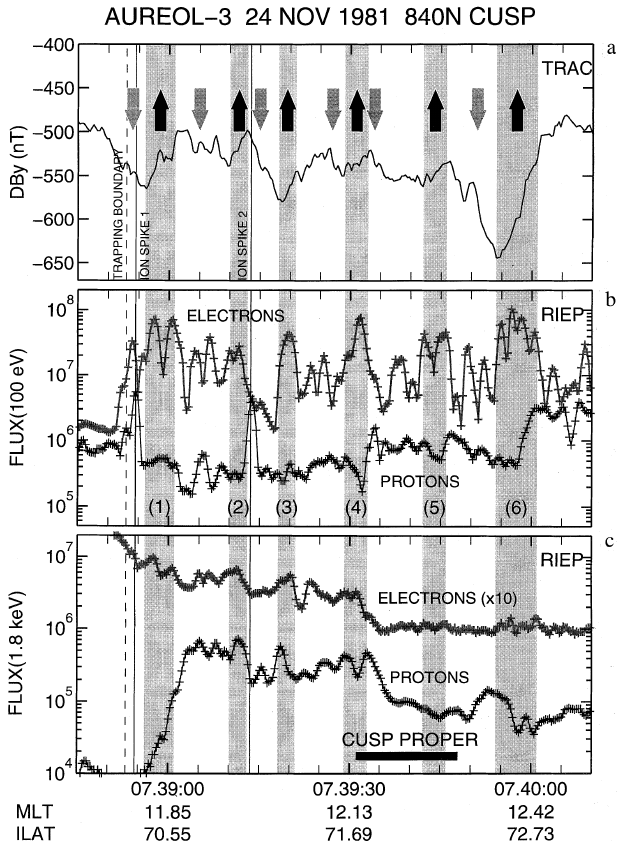
Fig. 4a–c. Expanded view showing 2:30 min of data. Electron flux at 1.8 keV ( c ) has been multiplied by a factor of 10. Successive upward field-aligned current sheets are indicated by vertical grey